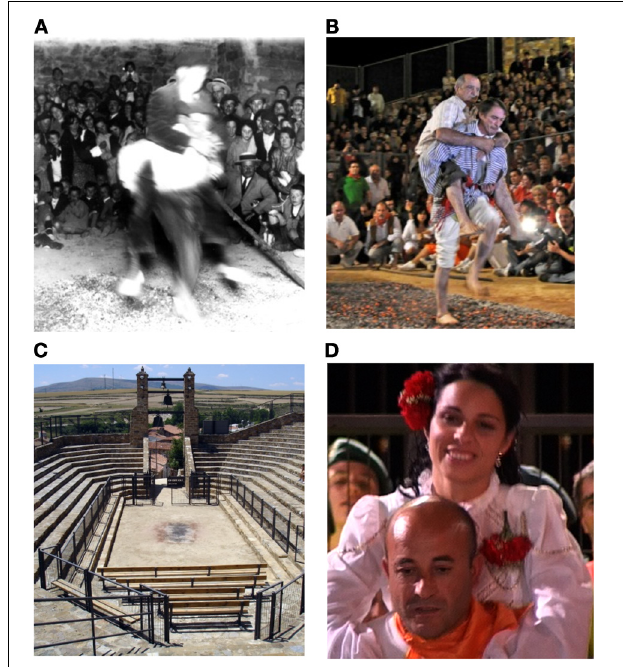
FIGURE 1 | Images from the San Pedro Fire-walking Ritual. (A) is an image of a walker/passenger dyad from the early twentieth century. (B) is an image from a contemporary fire-walking ritual. Qualitatively, it would appear that there is a strong conservation of this ritual form. Such conservation is puzzling because the ritual involves pain, though without any obvious benefits to health or prosperity. Functionalists posit indirect benefits to prosperity from social bonding. (C) shows the purpose-built theater constructed for this ritual, which accommodates roughly 3000 spectators. Note the scorch marks on the pavement from previous fires. (D) shows a typical rated image from the middle stage of a fire-walk, hinting at different valence in the expressions of this fire-walker and passenger